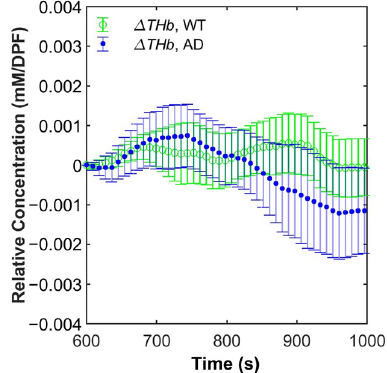
Figure 6. Grand average and 95% confidence interval of relative total hemoglobin concentration ( ∆ THb ) of WT (green circle) and AD (blue dot).